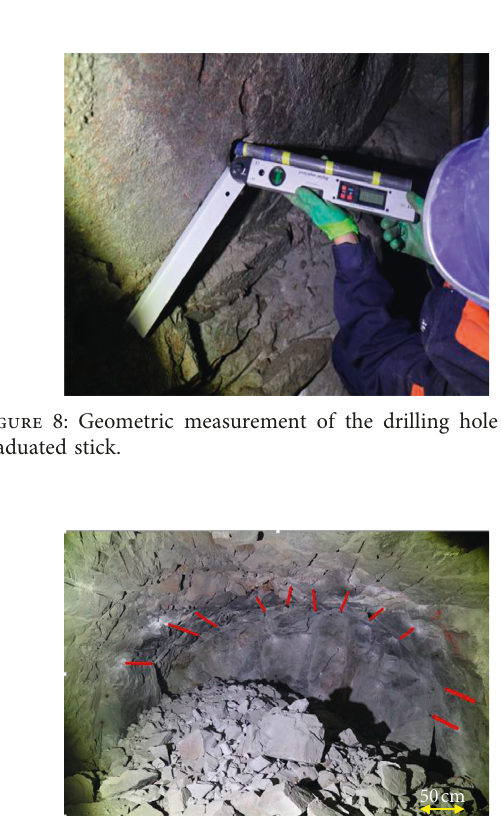
Figure 9: Blasting effect of straight parallel hole cutting.